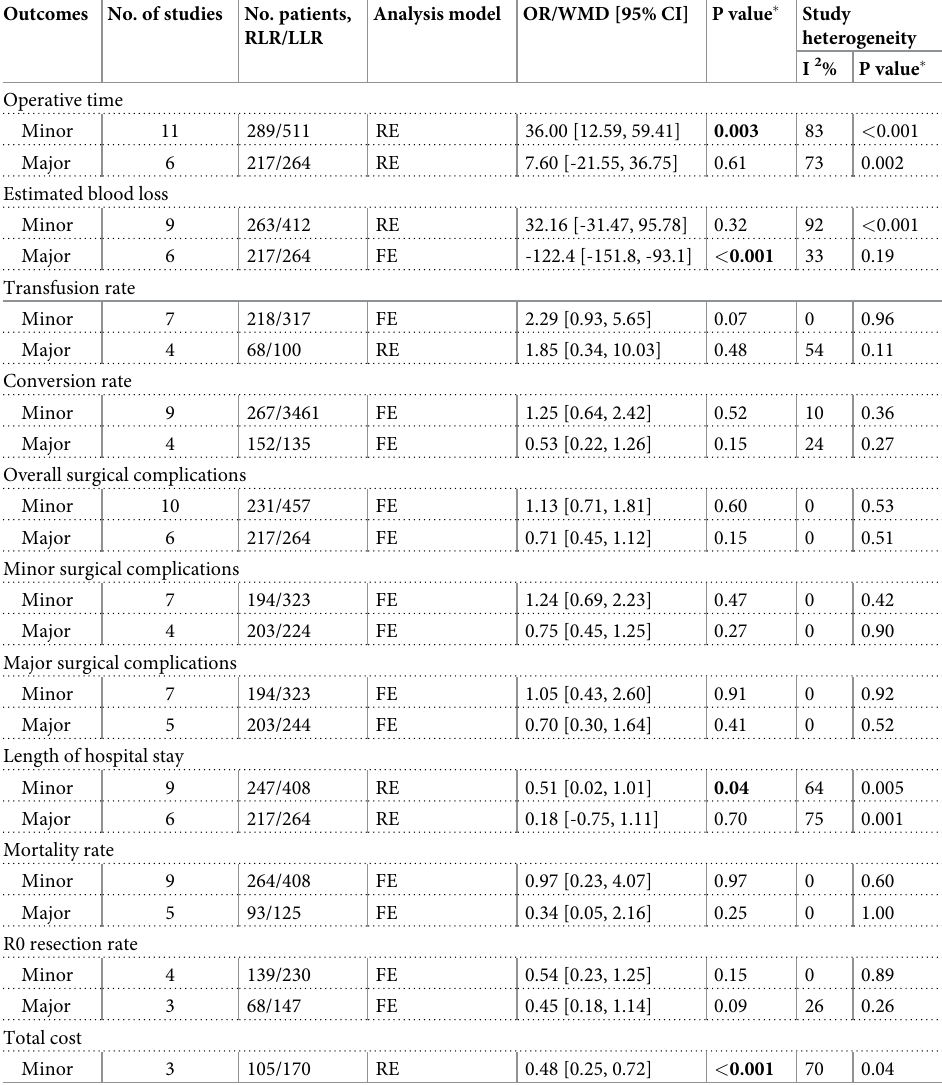
Table 3. Subgroup analysis of minor and major hepatectomy. Outcomes No. of studies No. patients,